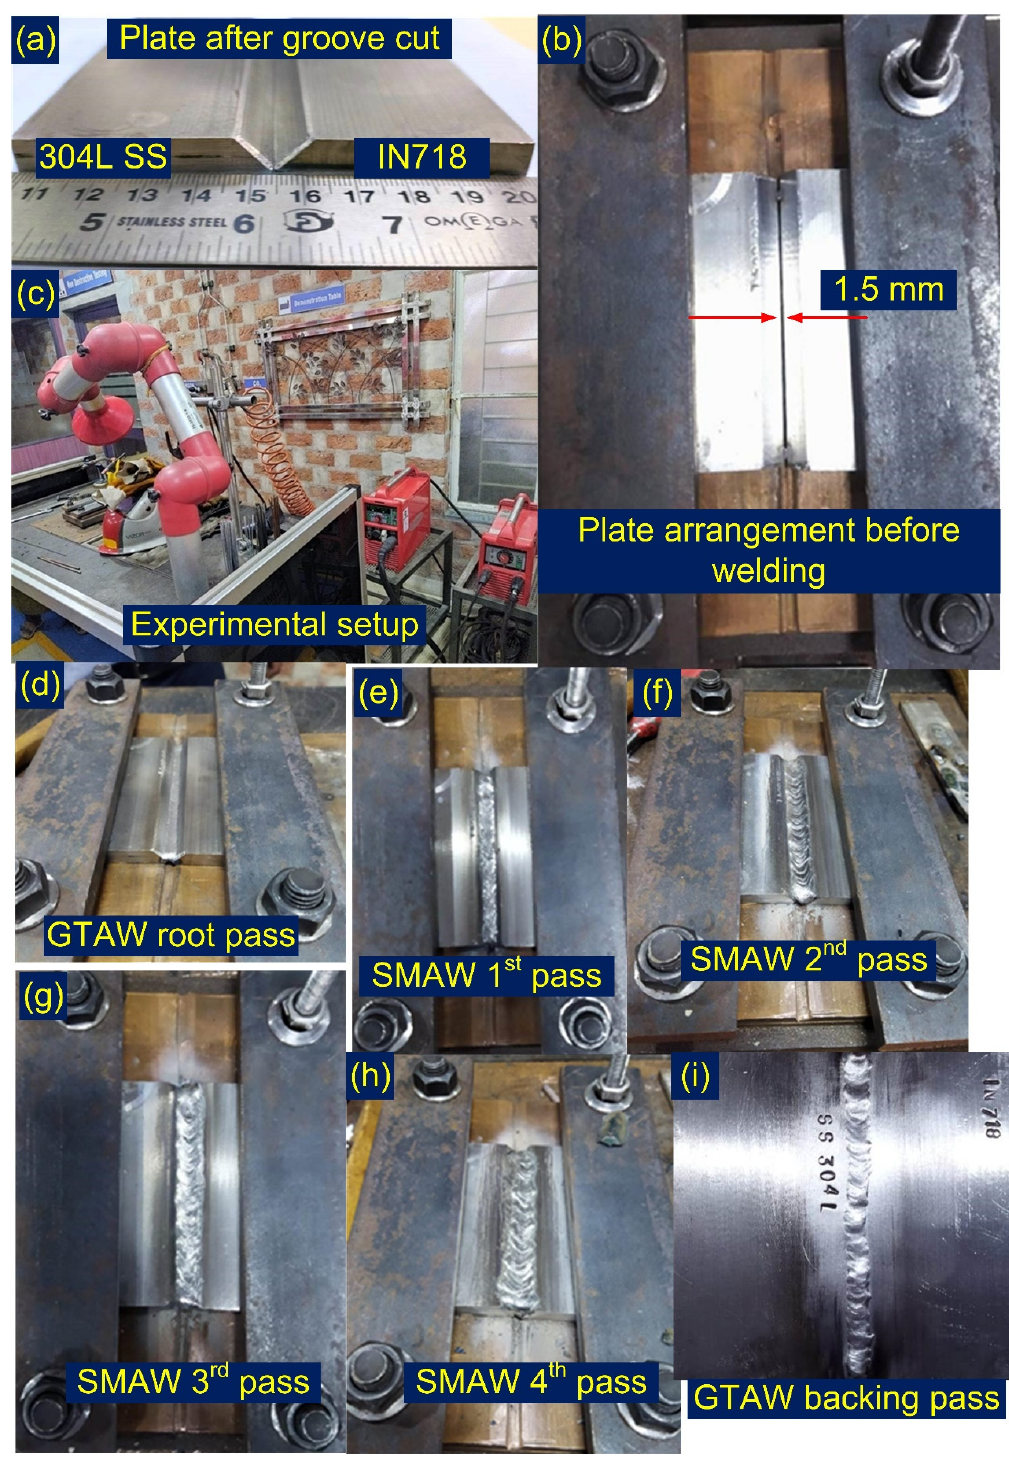
Figure 2. ( a ) Plate after groove preparation, ( b ) arrangement of the plate before welding, ( c ) welding machine setup, ( d ) plate after GTAW root pass, ( e – h ) SMAW filling passes, ( i ) backing GTAW pass. The heat input is calculated using the following Equation (1)